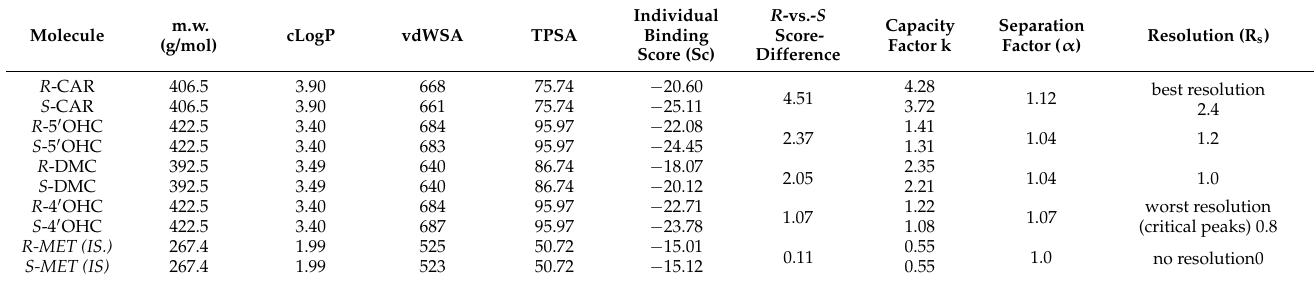
Table 4. Molecular/physicochemical parameters of analytes (CAR enantiomers, metabolite enan- tiomers, and internal standard enantiomers), individual CSP-binding scores, score differences of analyte pairs, and chromatographic characteristics under optimized conditions.